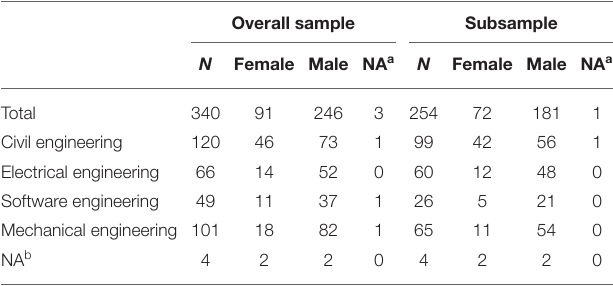
TABLE 1 | Total number of participants, gender, and study program distribution. Overall